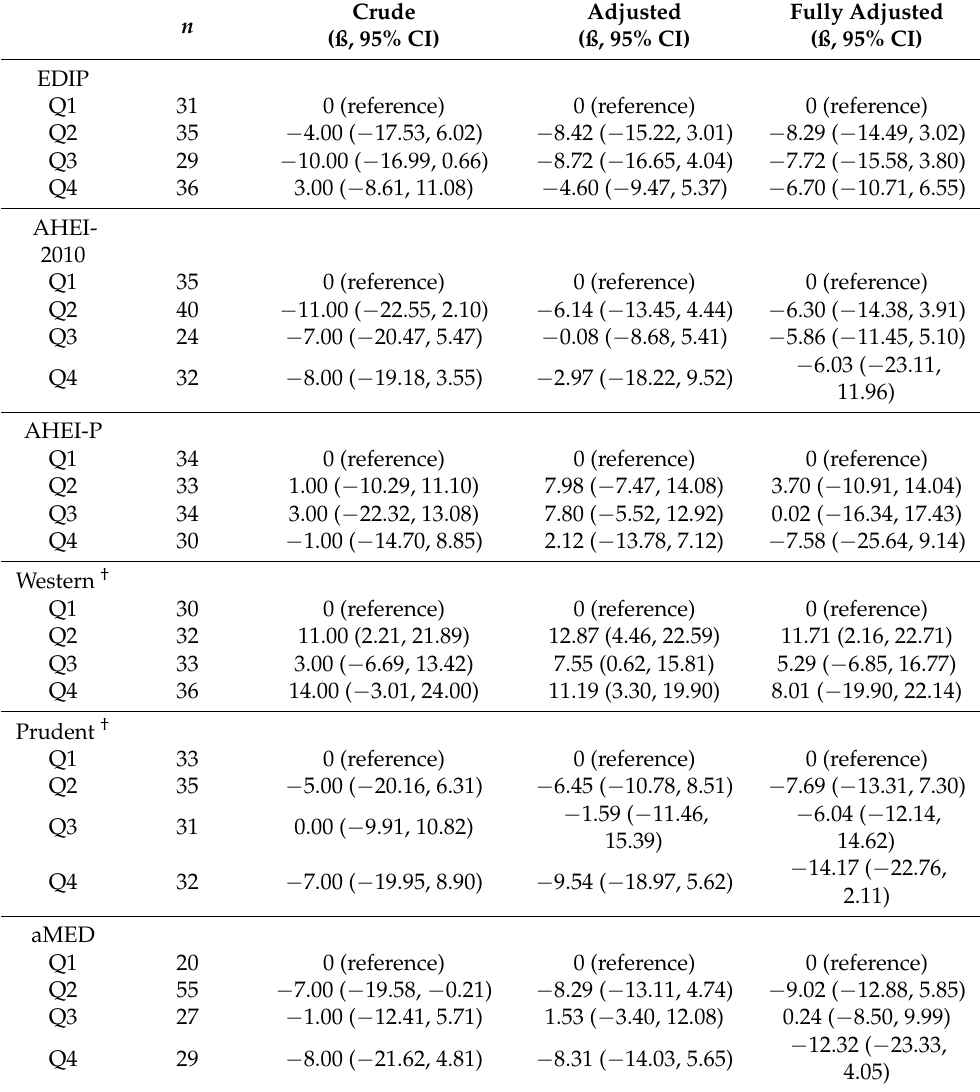
Table 2. Association between maternal dietary patterns during pregnancy and child SRS raw scores in EARLI ( n =